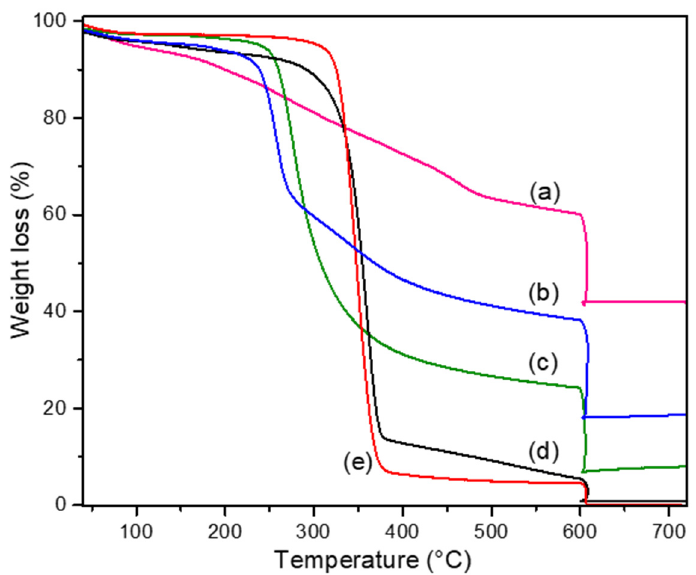
Figure 2. TGA curves for: (a) CCuNP10.0, (b) CCuNP5.0, (c) CCuNP2.5, (d) untreated cellulose, (e) heat-treated cellulose.